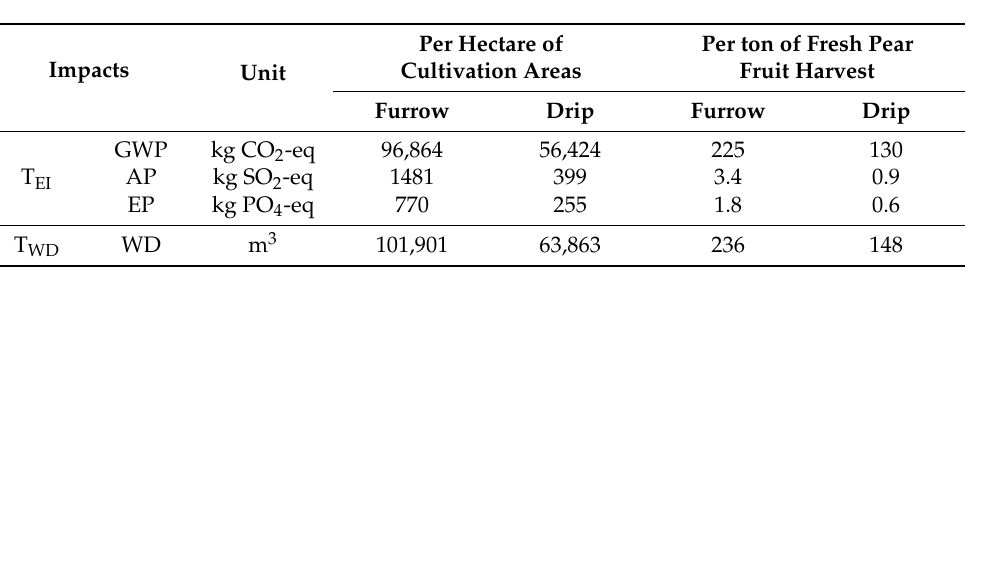
Figure 4. Annual GWP, AP, and EP expressed per ton of the fruit of furrow and drip irrigation pear production system in different phases. Phase II–IV represent the primary growing phase, the low production phase, and the full production phase, respectively. AMS and OMS are the abbreviation of the agriculture materials input stage and orchard management stage, respectively. Different letters represent significant differences ( p < 0.05) among the phases (a, b). Table 2. The total global warming, acidification, eutrophication impacts, and water depletion during